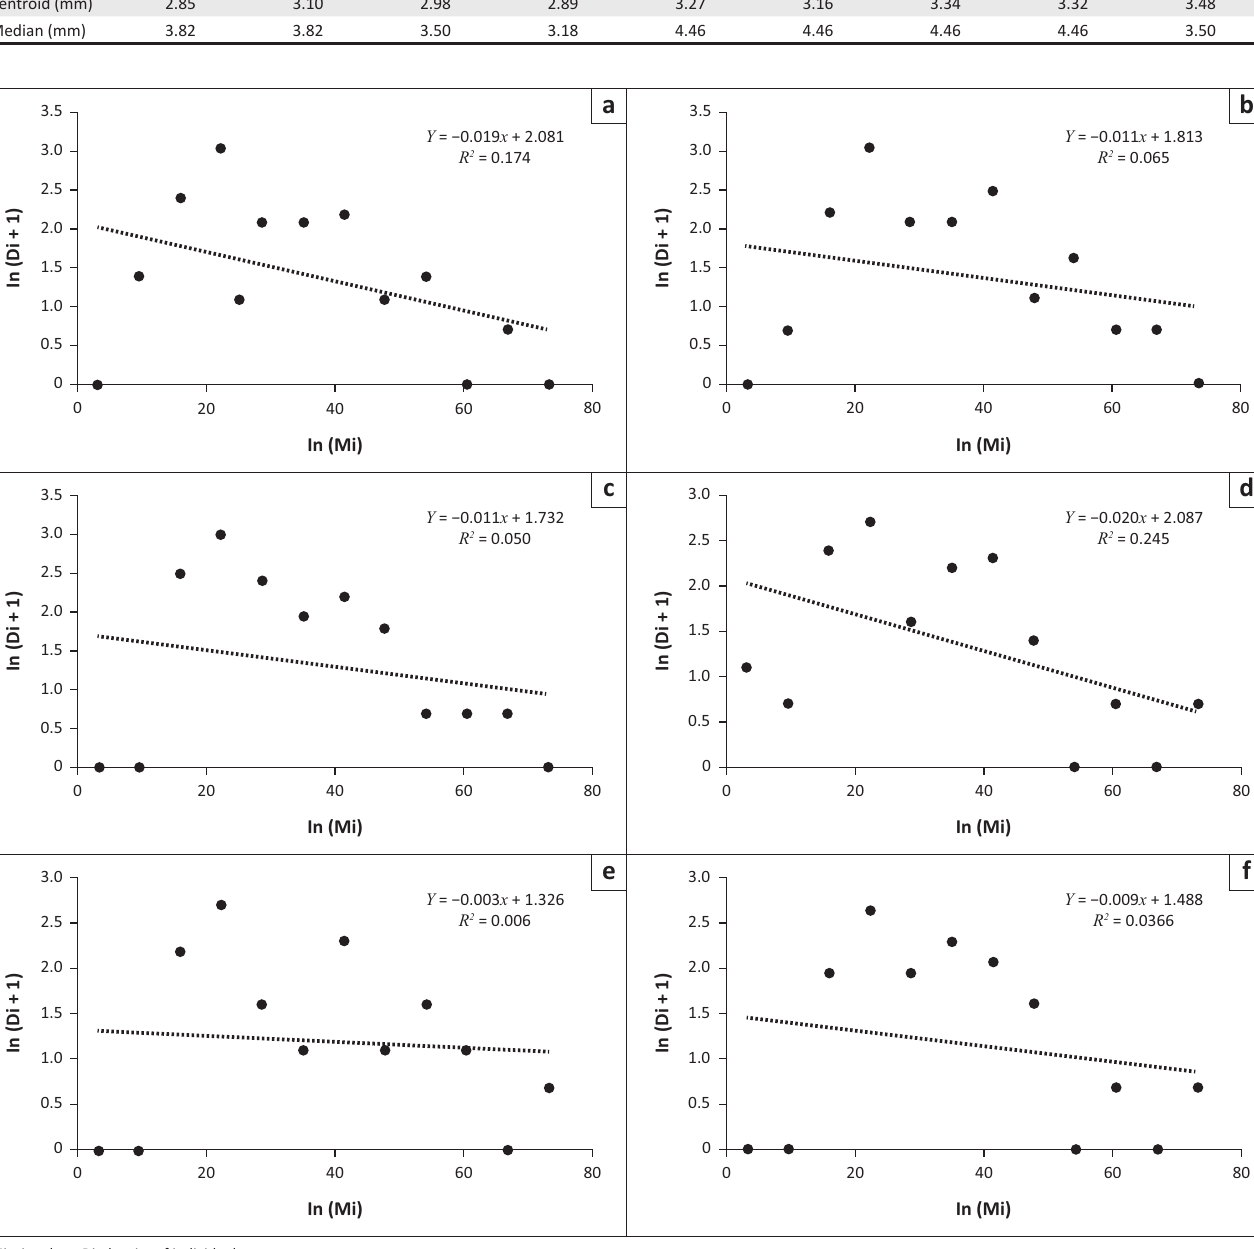
FIGURE 1-A1: Linear regressions fitted on the ln (Mi) against ln (Di + 1) of live trees at Grootkolk in the Kalahari Gemsbok National Park in (a) 1979, (b) 1984, (c) 1986, (d) 1989, (e) 1994, (f) 1996, (g) 1999, (h) 2008 and (i) 2016, where Mi, midpoint of the size class and Di, density of